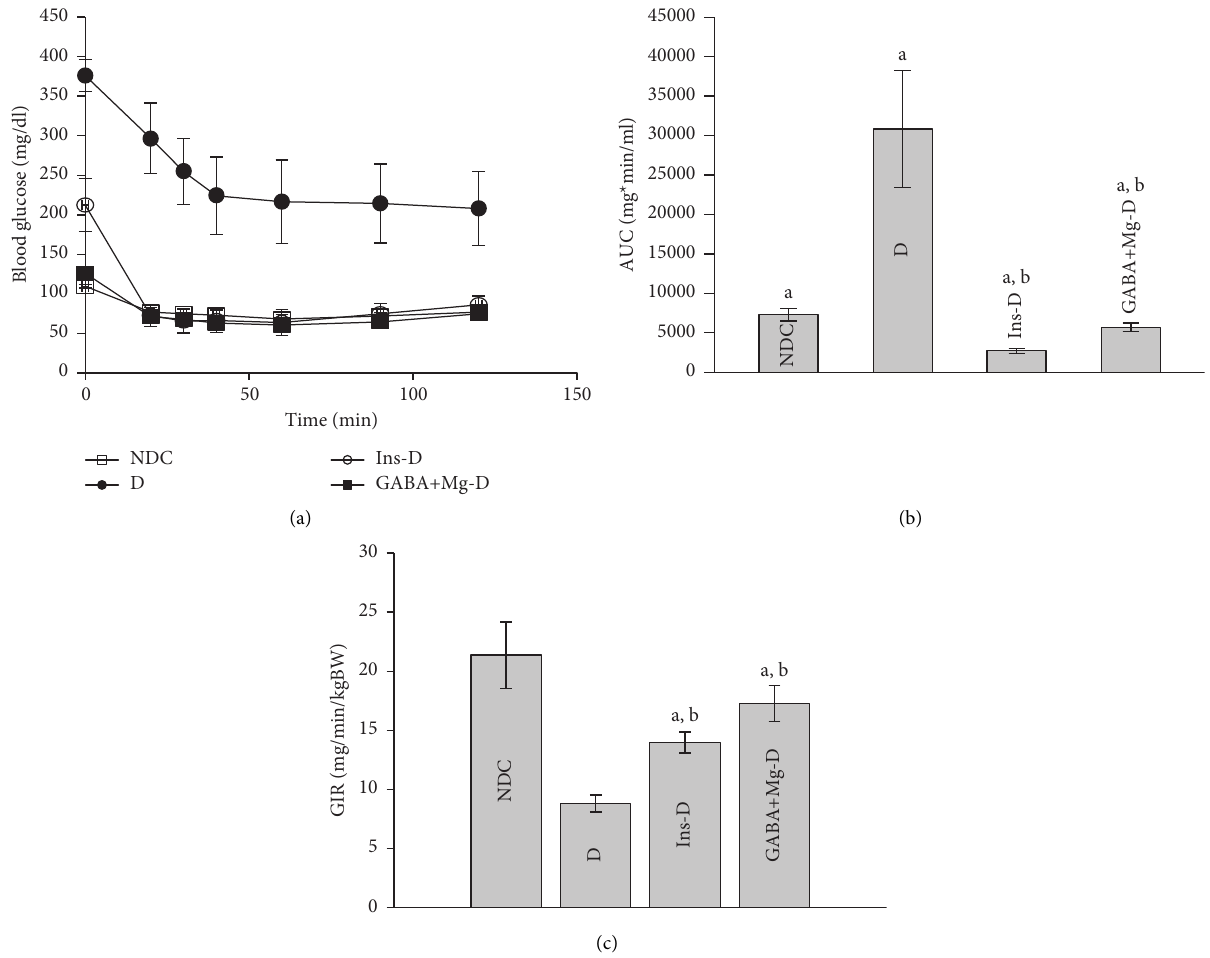
Figure 2: Comparison of insulin tolerance test (a) and the area under the glycemic curve (AUC) (b) and GIR (c) 3 months after treatment in the nondiabetic control group (NDC) who received a normal diet, the group with chronic diabetic fed high-fat diet and 35mg/Kg STZ (d), diabetic animals treated with insulin (2.5 U/Kg two times per day) (Ins-D), and animals with diabetes receiving GABA treatment GABA (1.5gr/kg) +MgSO 4 (10g/l add in drinking water) (GABA +Mg-D) (10 rats in each group. Data are expressed as mean ± SEM). (a) Significant difference between D and other groups ( P < 0.0001). (b) Significant difference between GABA+Mg-D and Ins-D group ( P < 0.001). (c) Significant difference between NDC group and GABA+Mg-D ( P <